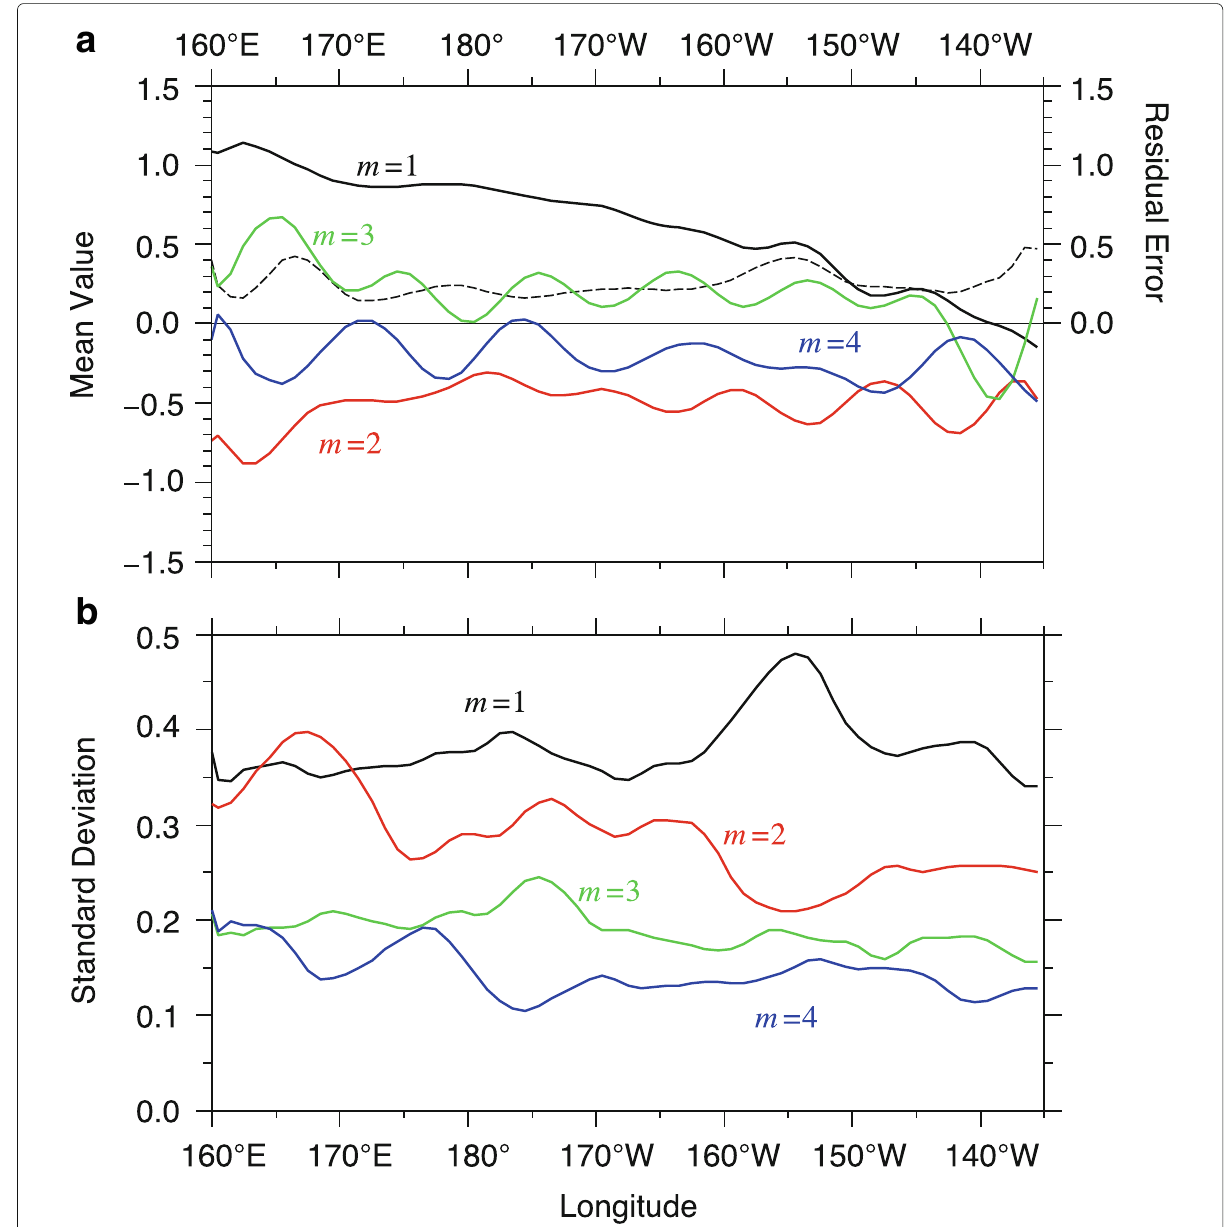
Fig. 5 Longitudinal distributions of a the mean value and b the standard deviation of W m (10 − 6 ms − 1 ) in Eq.(6). Values of the first ( m = 1), second ( m = 2), third ( m = 3), and fourth ( m = 4) modes are shown by black, red, green, and blue lines, respectively. In panel a , the mean residual error (10 − 6 ms − 1 ) of the Ekman pumping velocity, w E , for the four meridional modes is indicated by a dashed line